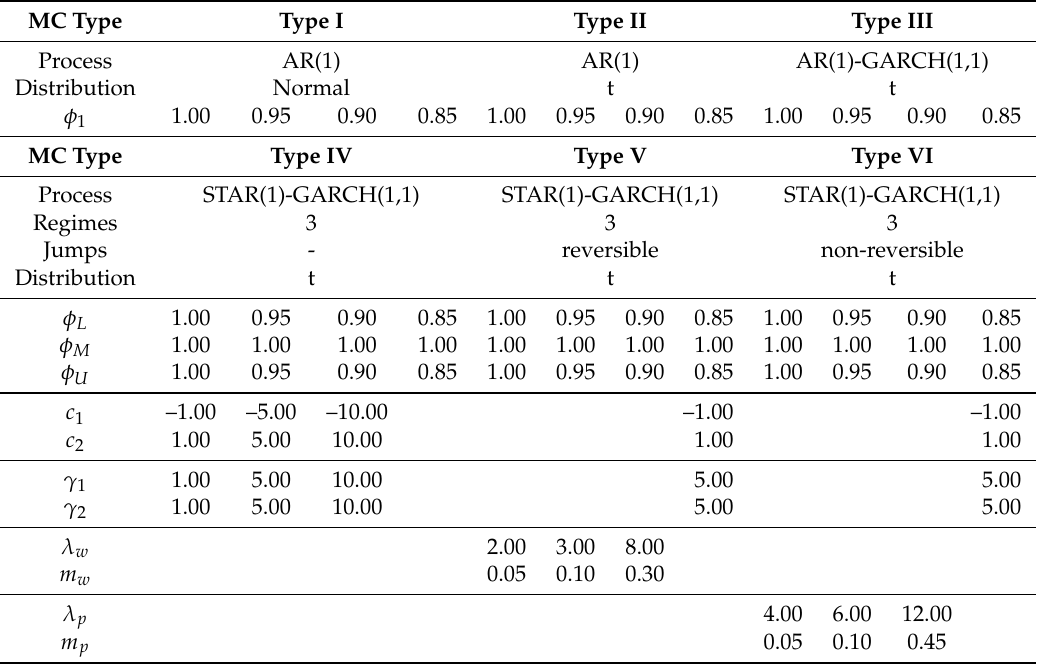
Table 6. Parameter settings for the six types of Monte Carlo simulations conducted in this study and described in Subsection 3.4.2. MC Type